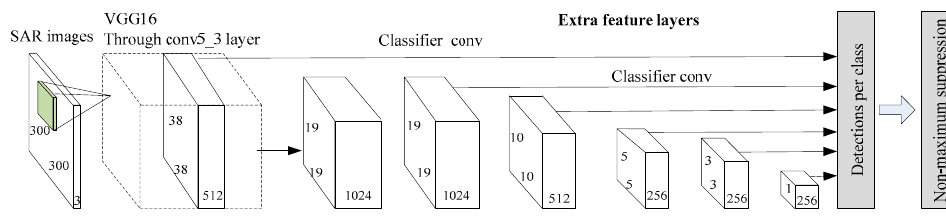
Figure 18. The structure of fused features in Faster R ‐ CNN.